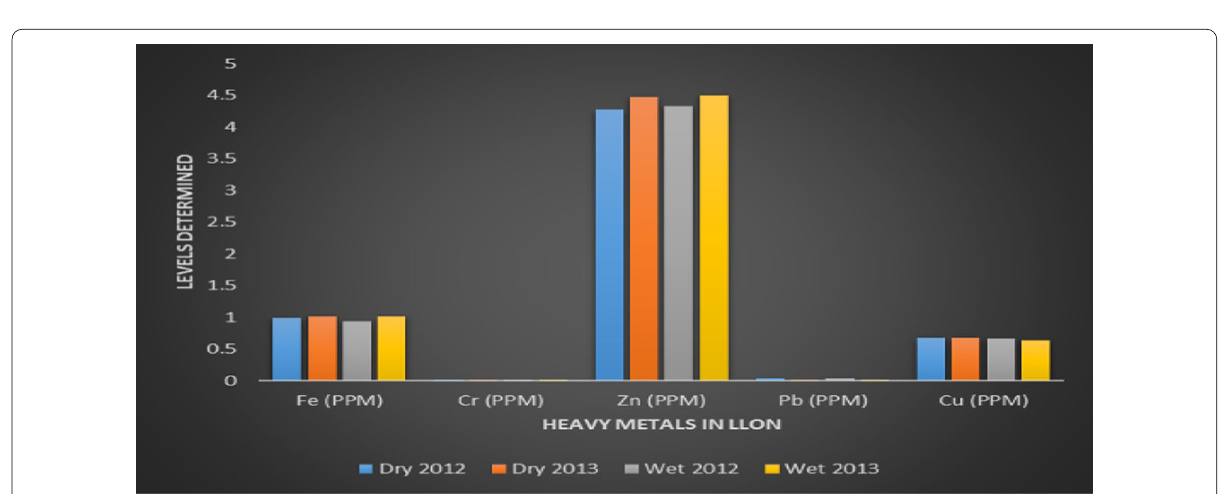
Fig. 9 Seasonal variations in heavy metals in O. niloticus collected from Lagos